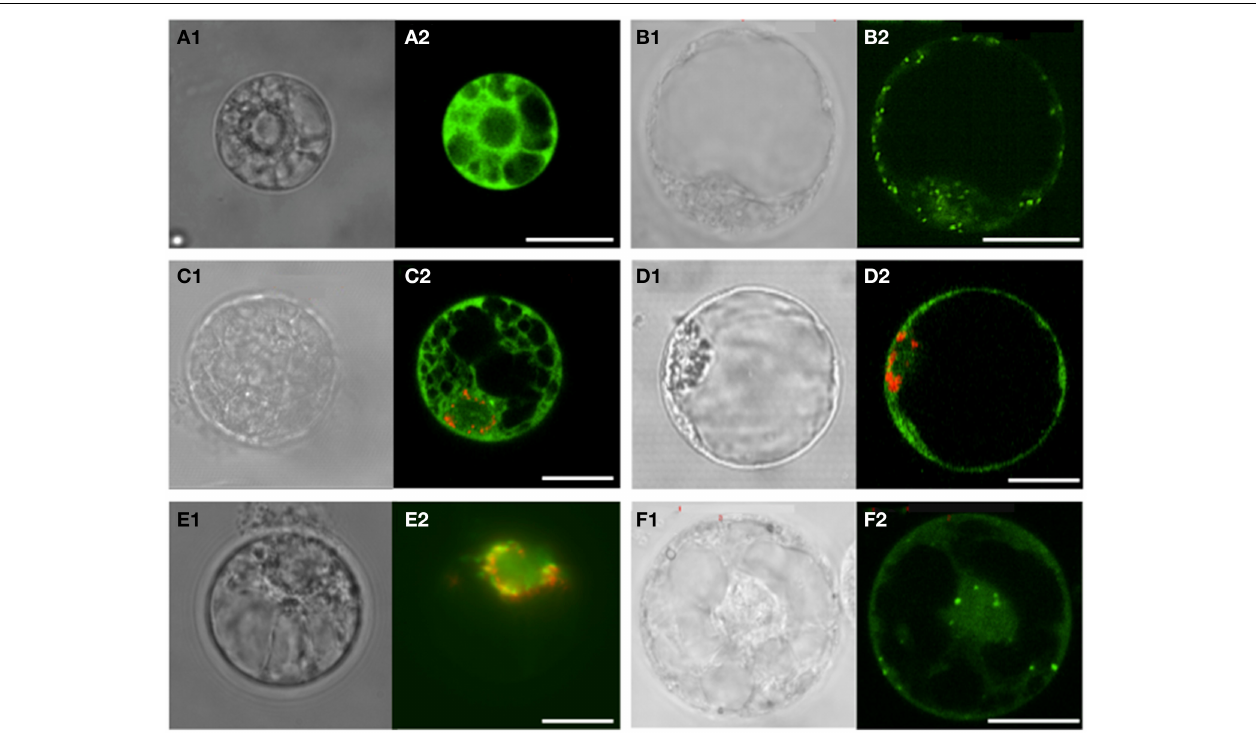
FIGURE 2 | Sub-cellular localization of GFP fused to the C-terminal sequences of Vitis vinifera cv Touriga Nacional SERAT proteins. Electroporation was carried out in V. vinifera protoplasts isolated from cell cultures. The signal expression and localization of GFP and RFP was observed between 24 and 48h incubation by confocal laser scanning or epifluorescence microscopy. (A) Plasmid pFF19-GFP used as control for localization into the cytosol; (B) SHMT-GFP carrying the transit peptide of Serine hydroxymethyltransferase (SHMT) from Arabidopsis as a control for